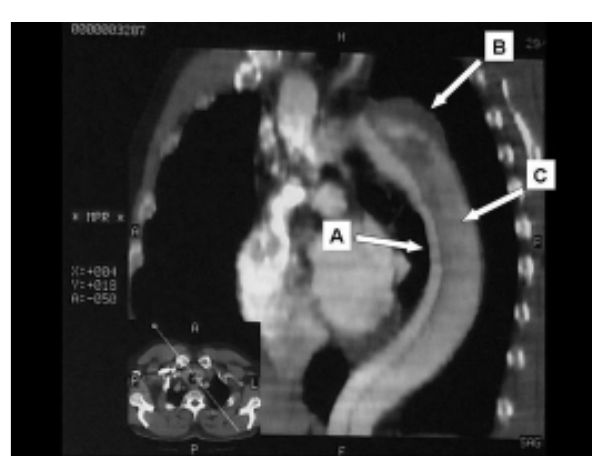
Fig. 1 – Tomografia computadorizada helicoidal de tórax. A- luz verdadeira; B- trombos organizados; C- luz